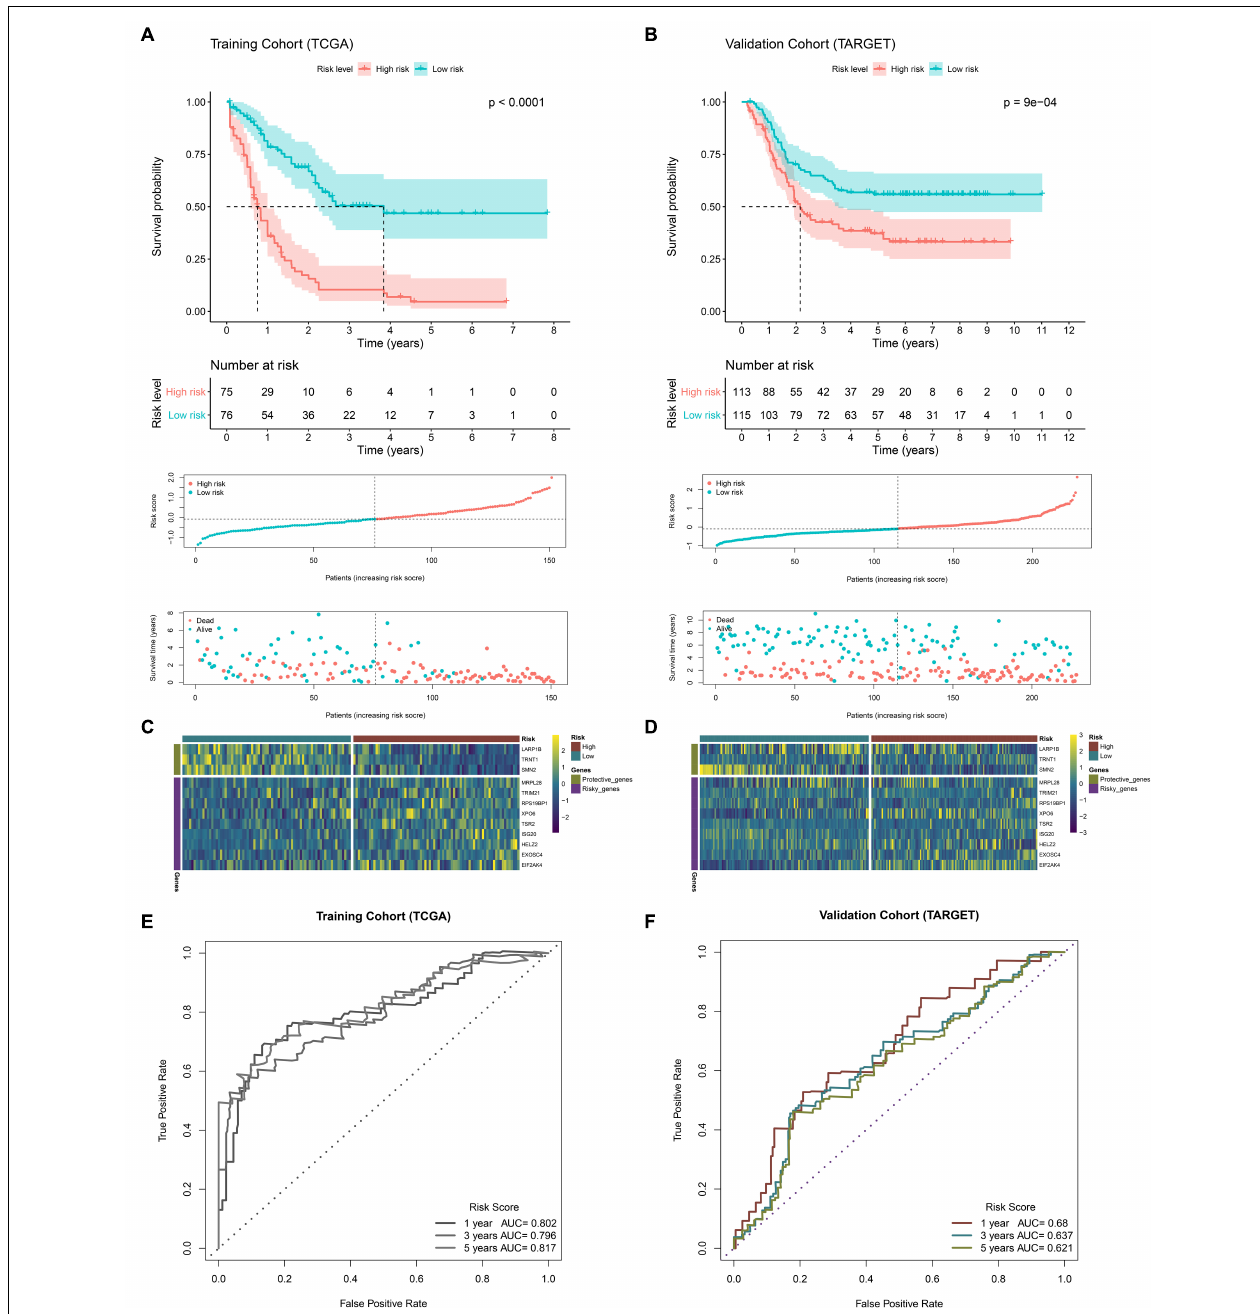
FIGURE 2 | Correlation analysis based on the 12-RBP signature. Survival analysis of high and low risks separated by the median value of the TCGA cohort risk score in the TCGA (A) and Therapeutically Applicable Research to Generate Effective Treatments (TARGET) cohort (B) . The heatmap shows the expression of the 12-RBP signature at high and low risks. The green module indicates protective genes with regression coefficient less than zero, and the purple module indicates risk genes with regression coefficient greater than zero (C,D) . ROC curve of risk score at 1, 3, and 5 years (E,F)